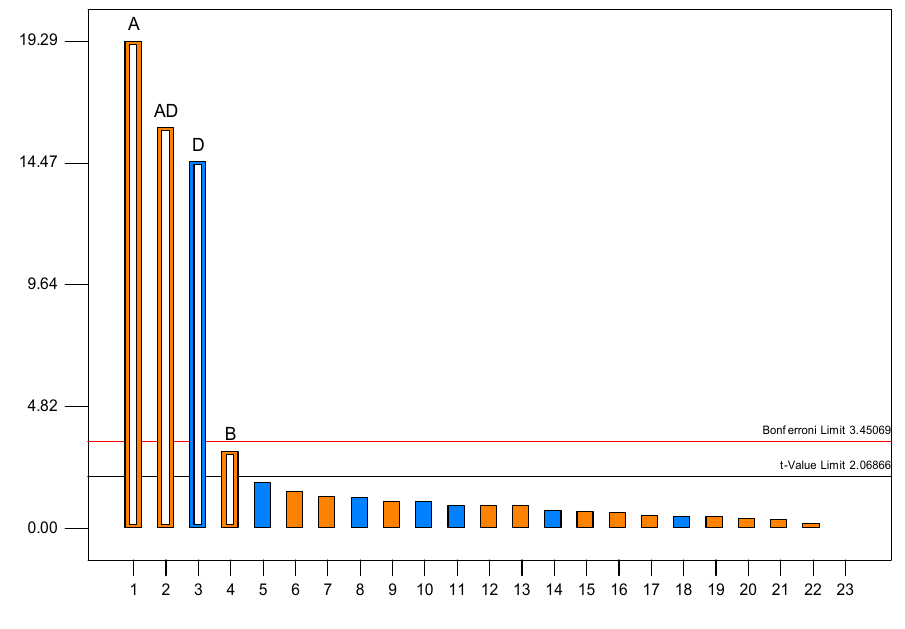
Figure 2. Pareto chart. A-MgSO 4 , D-CoCl 2 , B-CaCl 2